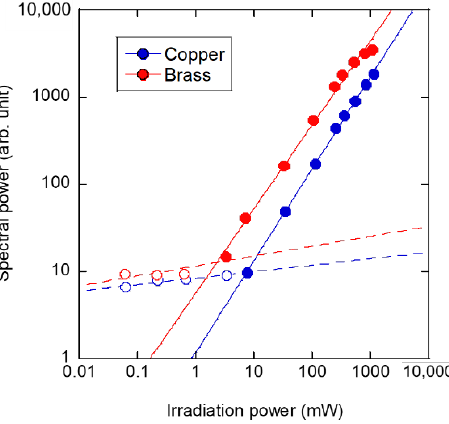
Figure 8. Irradiation power dependence of spectral power in characteristic vibration.